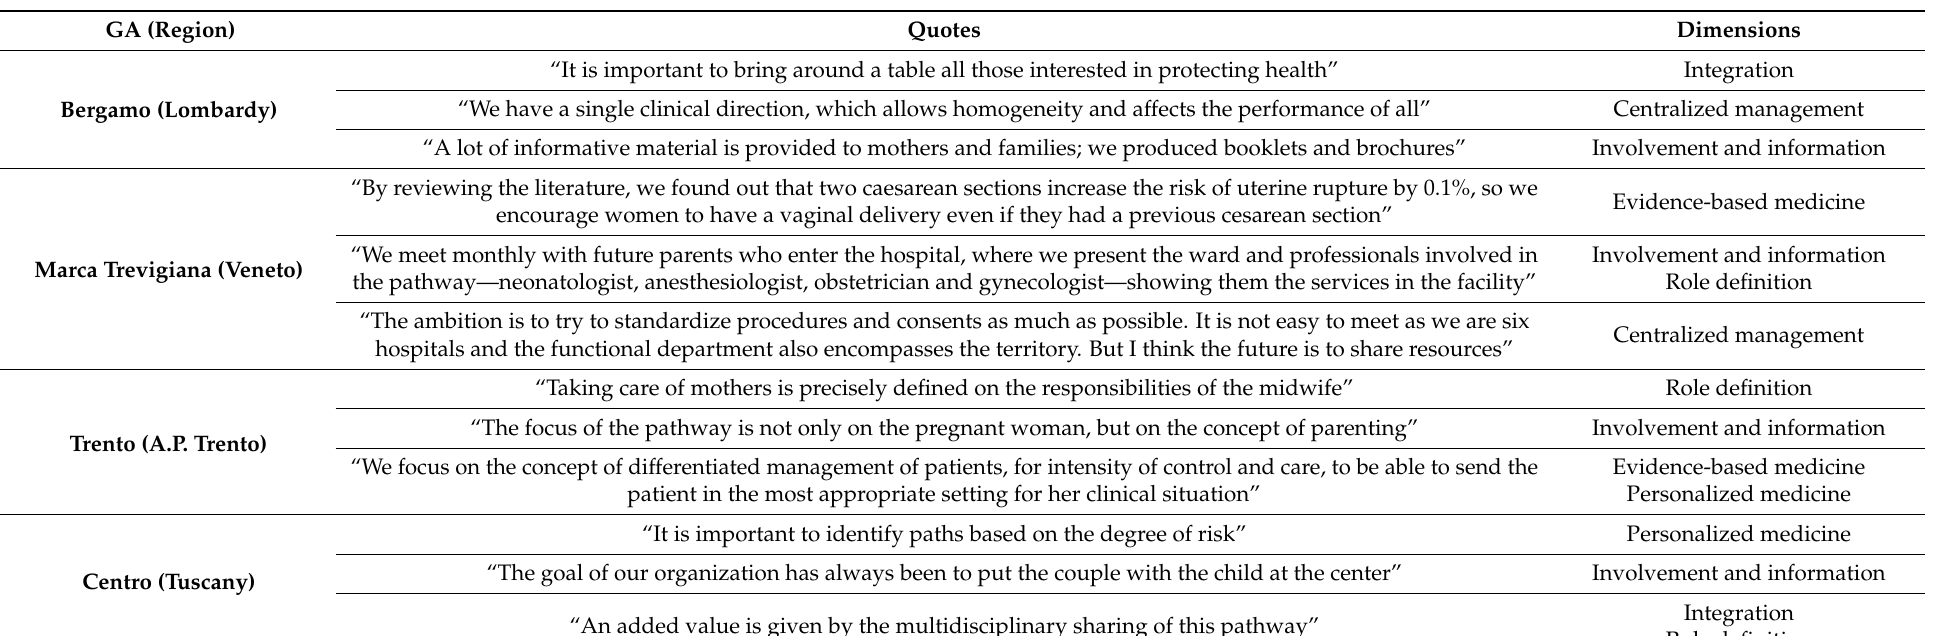
Table 3. Selection of representative quotes and identified dimensions from the anecdotal analysis. GA